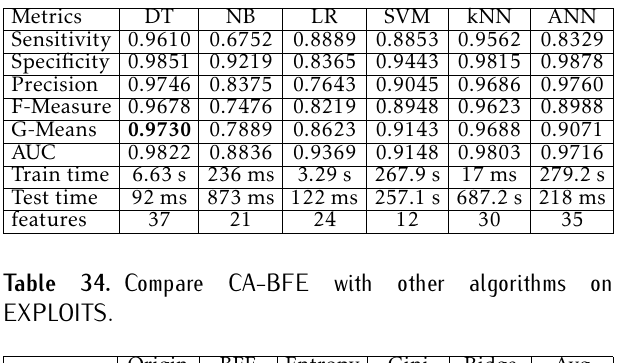
Table 37. Results of using CA-BFE algorithm on GENERIC.